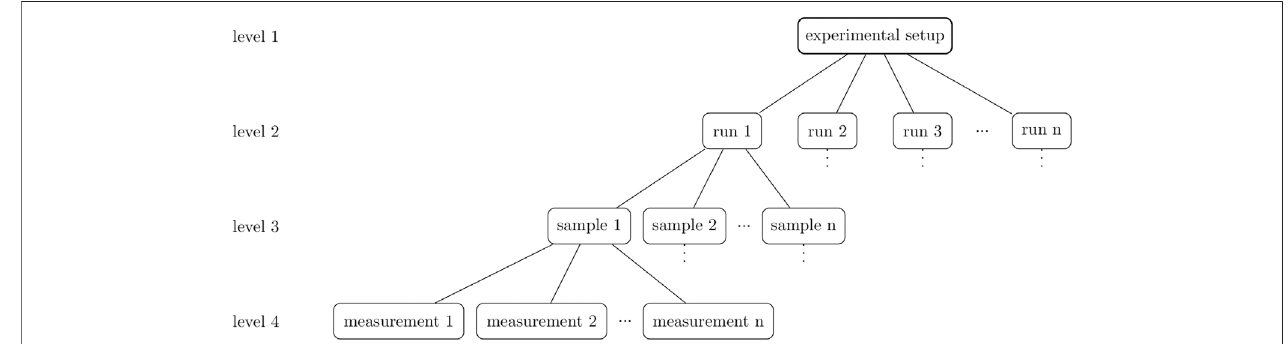
FIGURE 1 | A hierarchical overview of the experiment design. Level 1 includes the experimental setup, which for 3D bioprinting is represented, for example, by the bioprinterused,theprintingparameters,andthebioink.Level2consistsofbiologicalreplicates,theruns.Severalobjectscanbeprintedinonerunwhicharethesamples (level 3). These samples are technical replicates of the printing process and can be analyzed in a further step. The result is a measurement and in the case of a multiple determination, these measurements are also technical replicates of the analysis